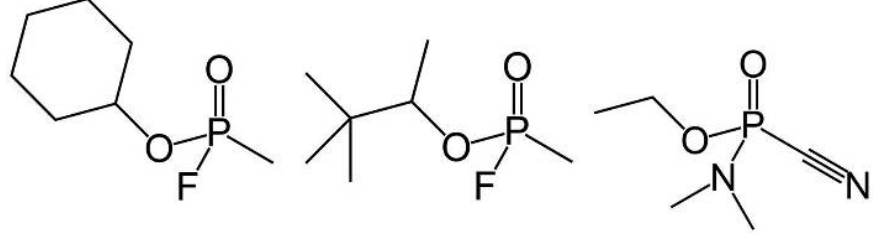
Figure 1. Structures of the neurotoxic agents Cyclosarin ( left ), Soman ( center ) and Tabun ( right ), respectively.